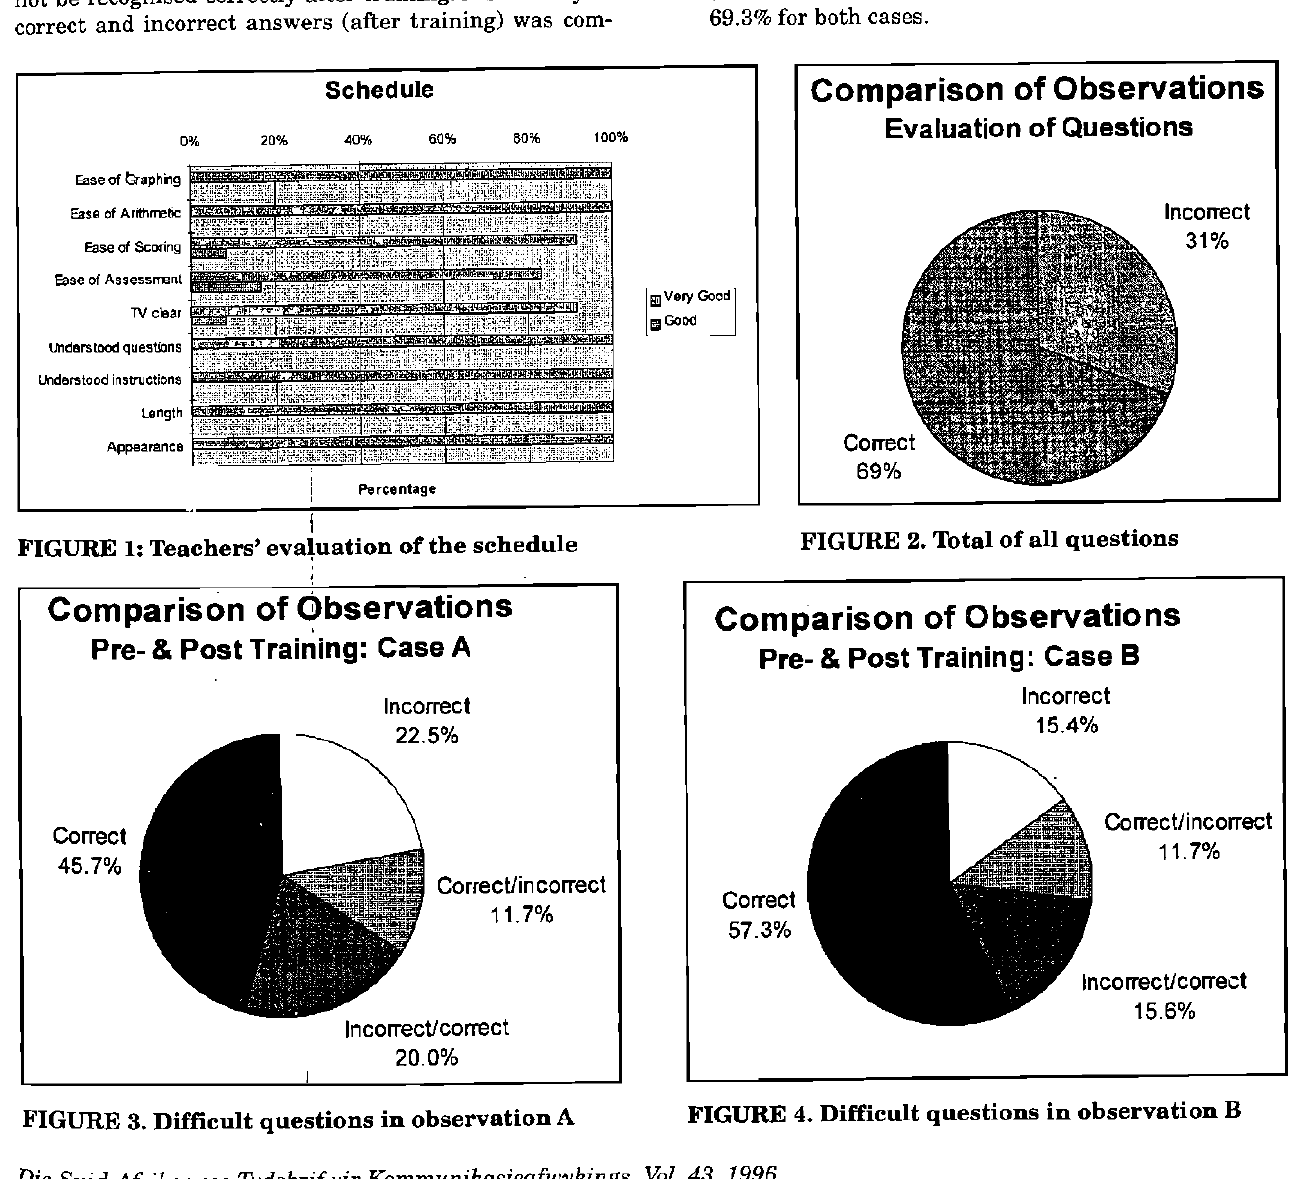
FIGURE 3. Difficult questions in observation A FIGURE 4. Difficult questions in observation